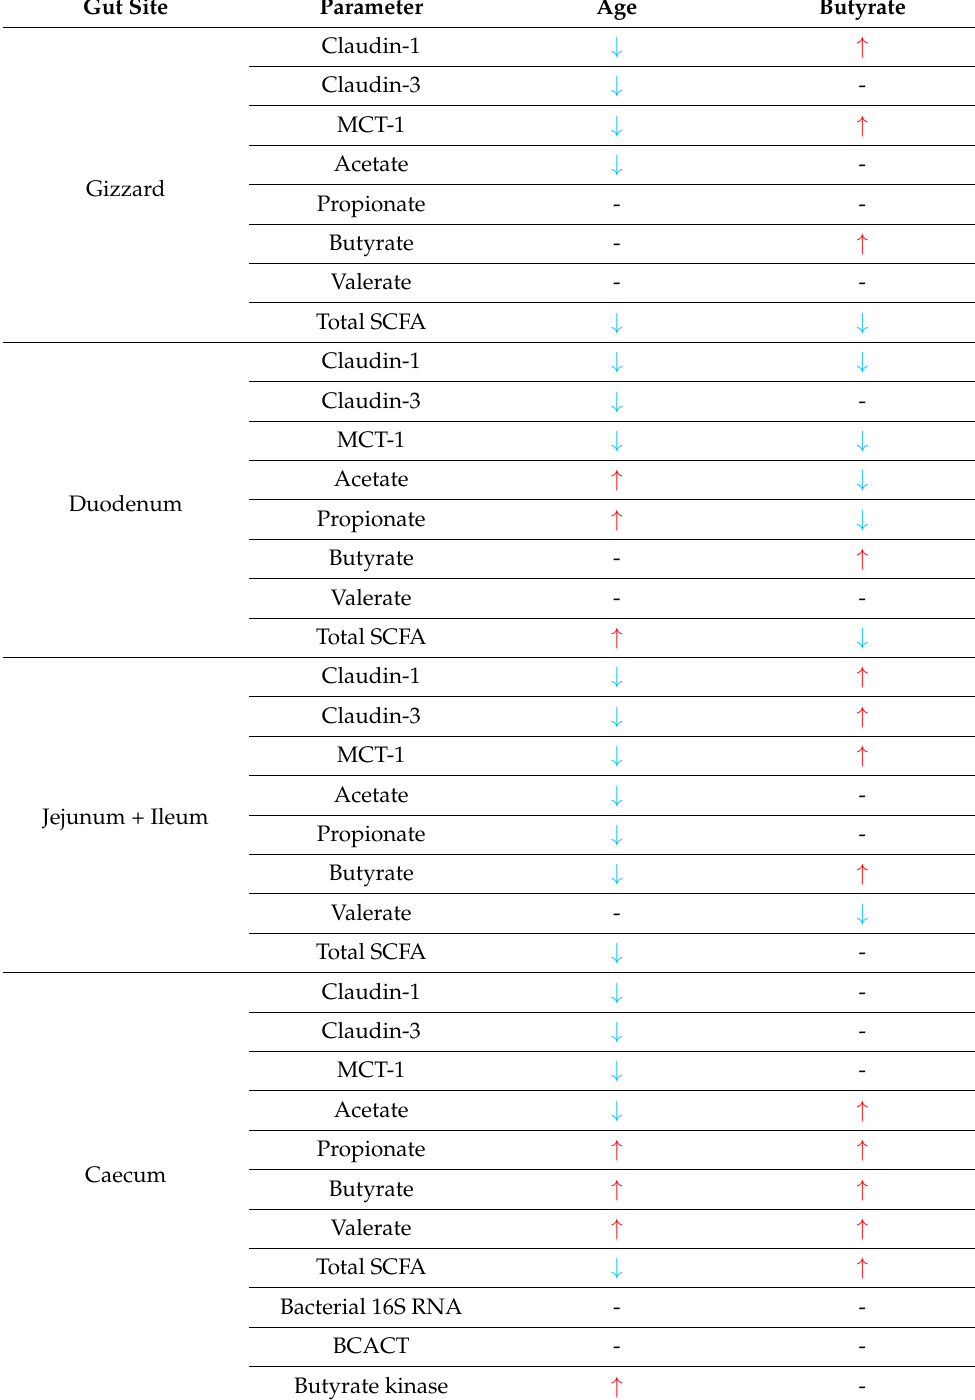
Table 6. Overview of the significant ( p < 0.05) effects of age and dietary treatment obtained in the gut mechanism study. Upstream arrows ( ↑ ) refer to significantly increased, while downstream arrows ( ↓ ) indicate significantly declined means of day 10 vs. day 21 or butyrate supplemented vs. control